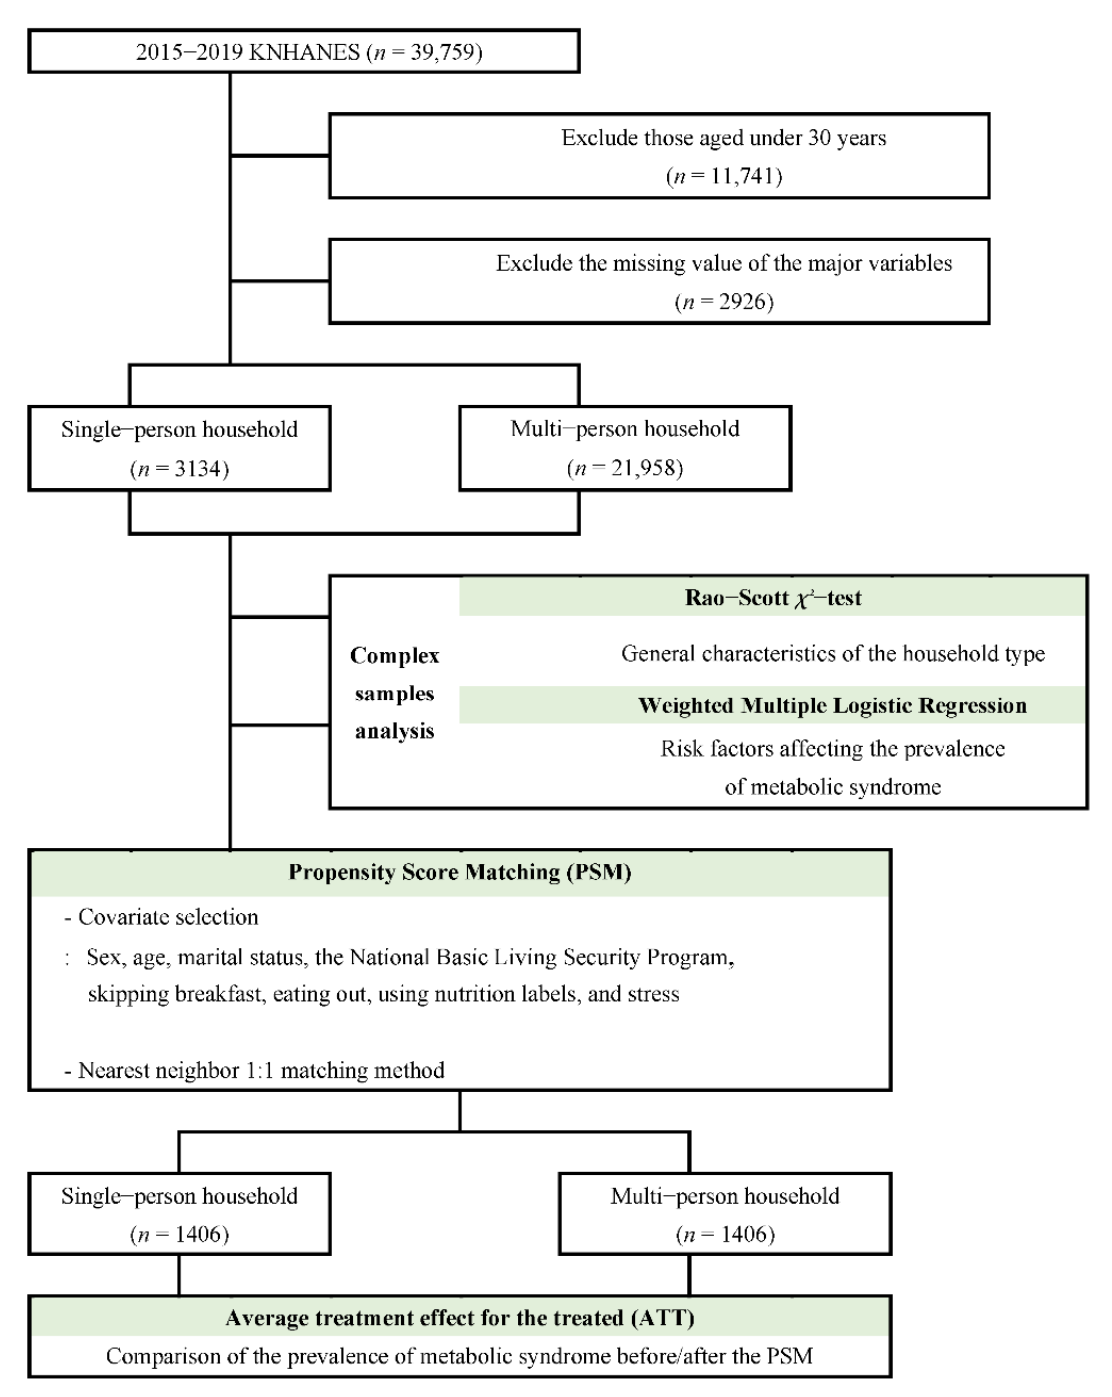
Figure 1. The conceptual framework of the research.